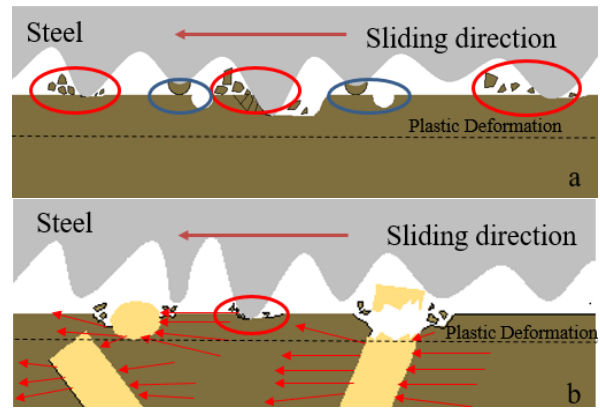
Figure 9: Wear mechanisms of pure PEEK and PEEK/ SBF; (a) wear mechanism of PEEK; red label is abrasive wear, blue label is adhe- sive wear; (b)wear mechanism of PEEK/ SBF; red and blue labels are abrasive and adhesive wear, respectively; red arrows indicate the stress transfer between